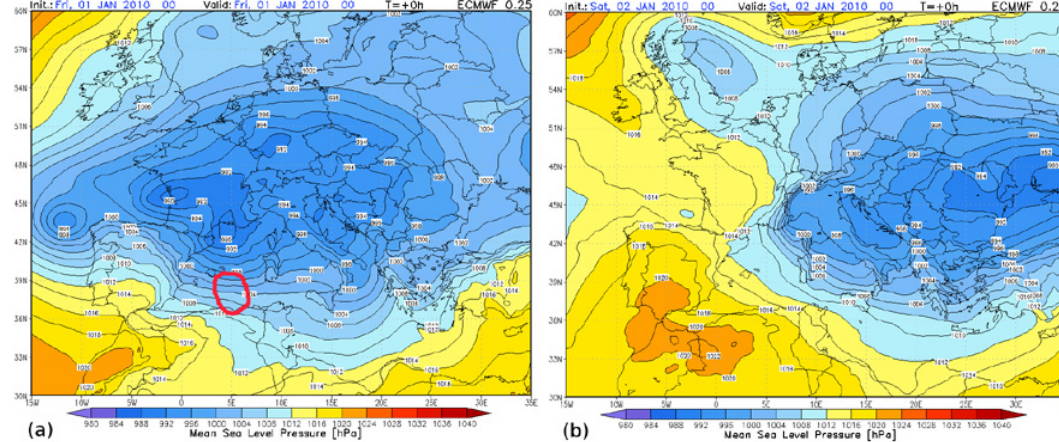
Figure 2. Mean Sea Level Pressure (hPa) from ECMWF analysis (bluish colors for low pressure values). Left panel (a) 00:00UTC on 1 January 2010 with main low pressure system over France and Lion Gulf at 990hPa, strong westerly baric gradient in the Central Mediterranean Sea. Red Circle indicates supposed generation area of swell component arrived in Ligurian Sea on 1 January 2010 early afternoon. Right panel (b) 00:00UTC on 2 January 2010 with main low pressure system over Balkans at 990hPa and strong north-westerly baric gradient over Central Mediterranean Sea.